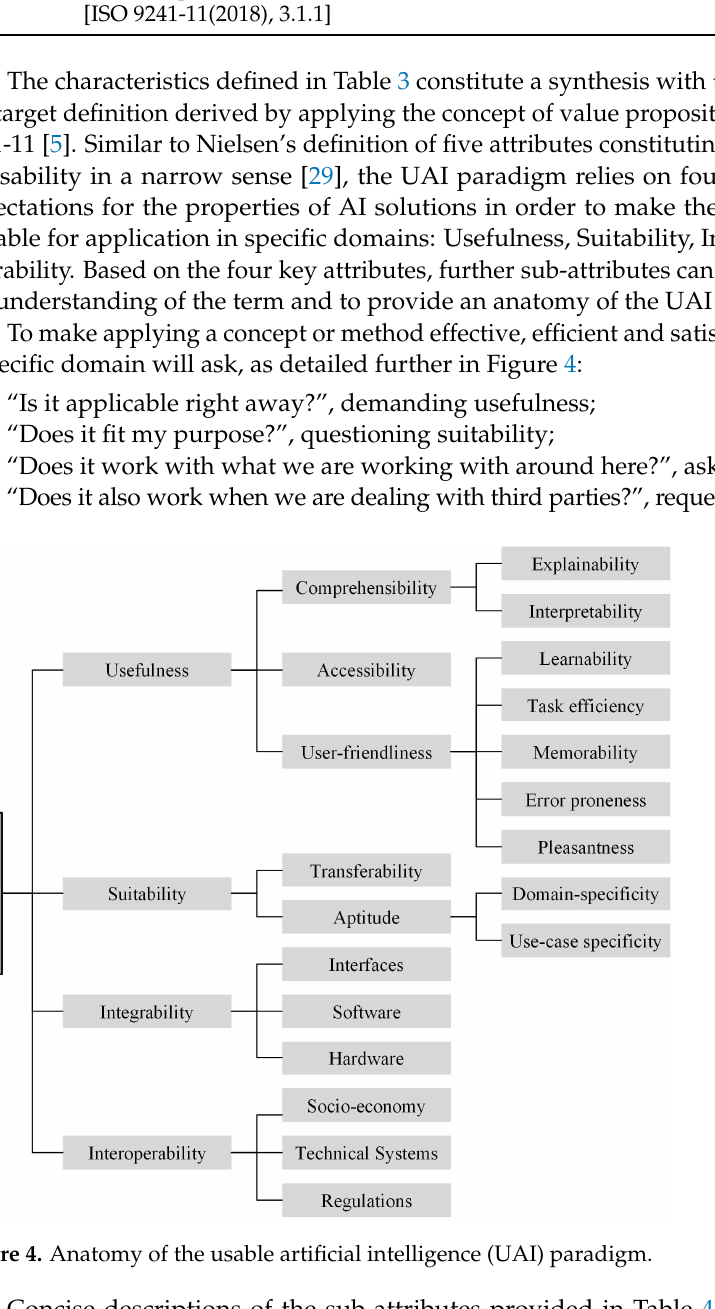
Table 4. Description of attributes of the UAI paradigm.